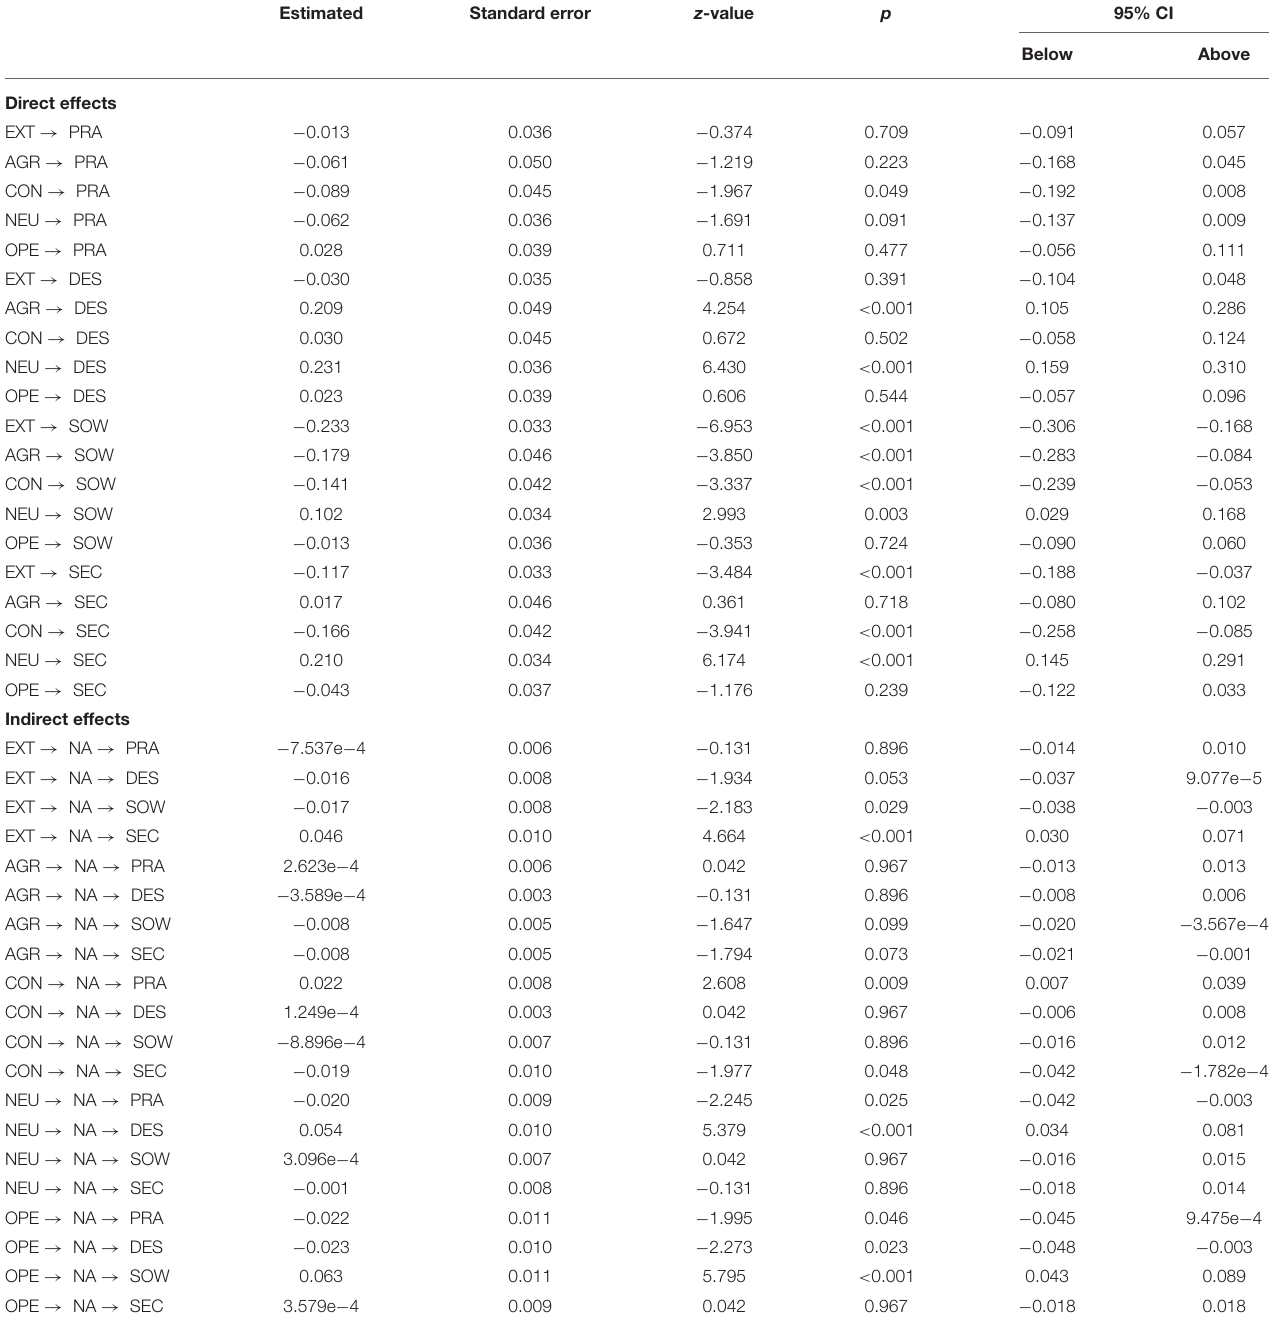
TABLE 4 | Direct and indirect effects (Model